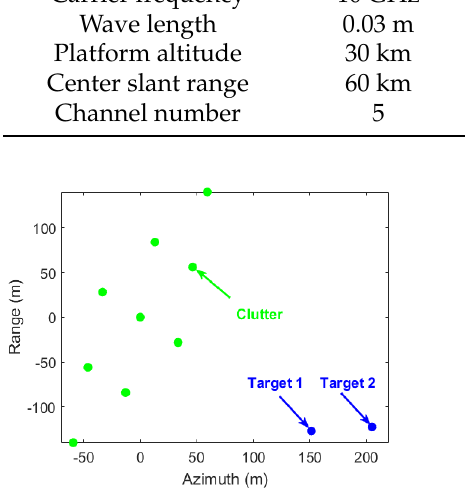
Figure 10. Distribution diagram of point scatterers.